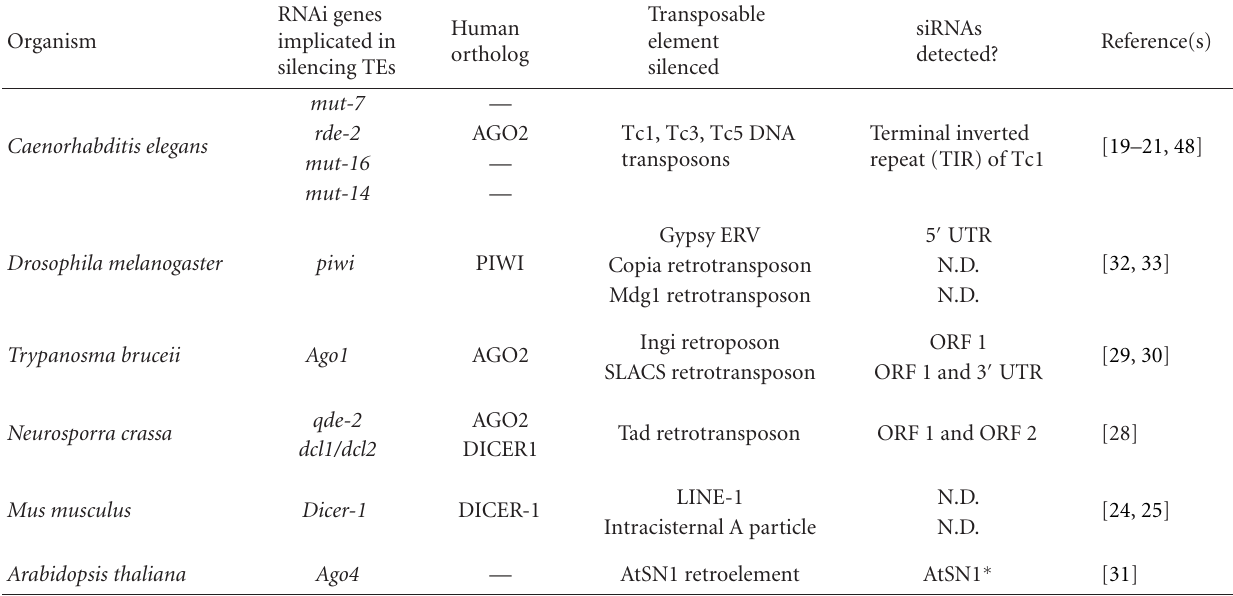
Table 1: Eukaryotic RNAi orthologs involved in silencing transposable elements. H sapiens orthologs, if present in the Homologene database, are indicated. N.D. implies not